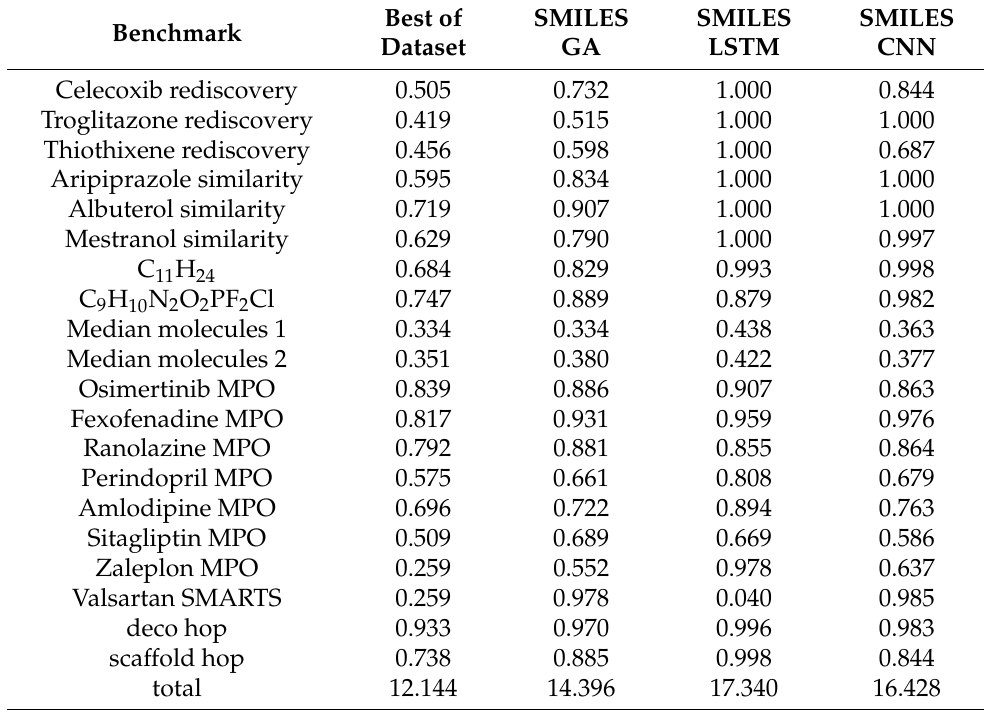
Table A1. Results of the generative models for the goal-directed benchmarks.